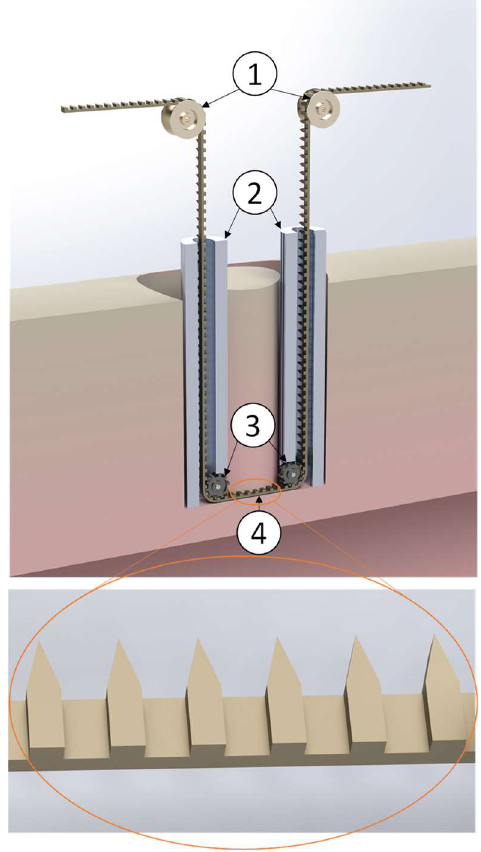
Figure 2. CAD model of donor root-side cutting mechanism showing (1) micro chainsaw guides inserted in donor profile (drilled), (2) pulley, (3) saw driver, and (4) micro saw (bottom) zoomed view of micro saw in action.